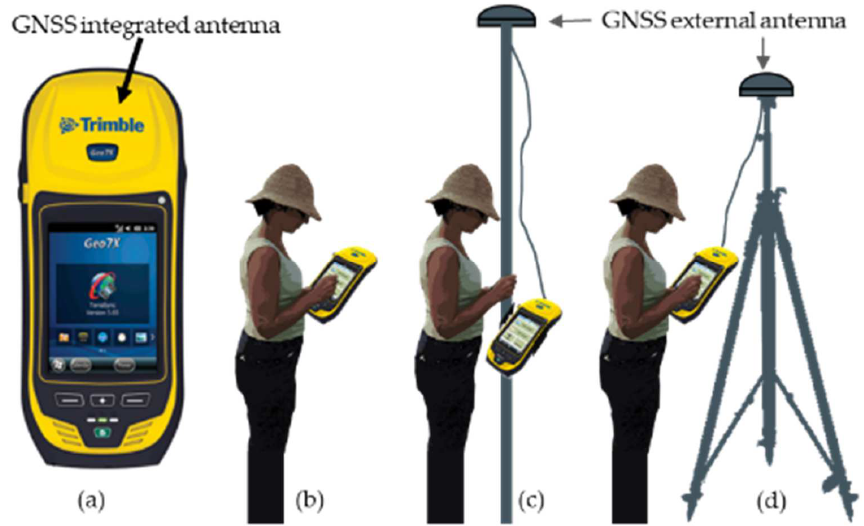
Figure 3. Trimble Geo7x GNSS receiver: ( a ) Geo7x with integrated antenna; ( b ) hand-held mode; ( c ) external antenna on a pole; ( d ) external antenna on a tripod.